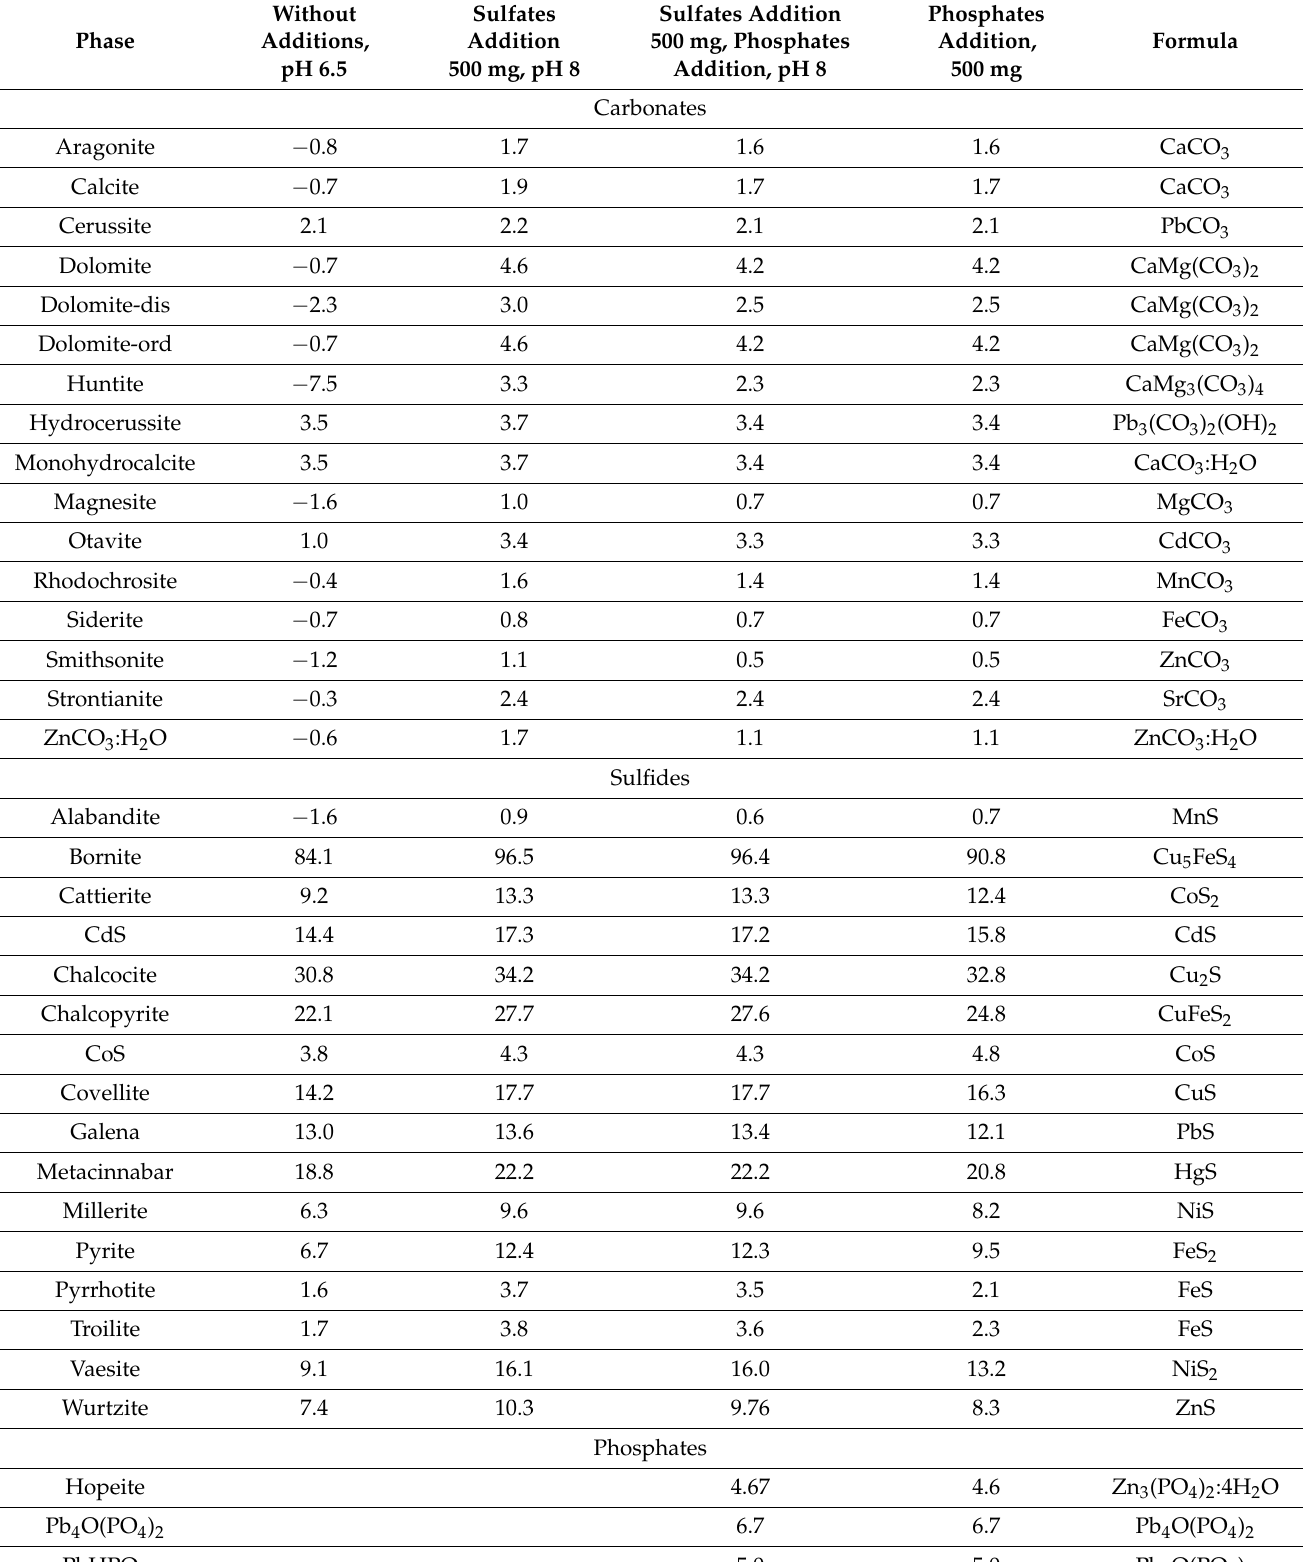
Table 6. Thermodynamic modeling (PhreeqC 2.1 software with the llnl.dat) of mineral phases formation at saturation indices (SI) >